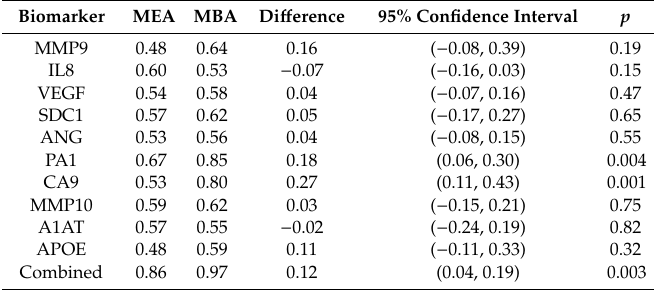
Table 4. Assay area under the ROC curve (AUROC) comparisons of MEA and MBA for bladder cancer diagnostic